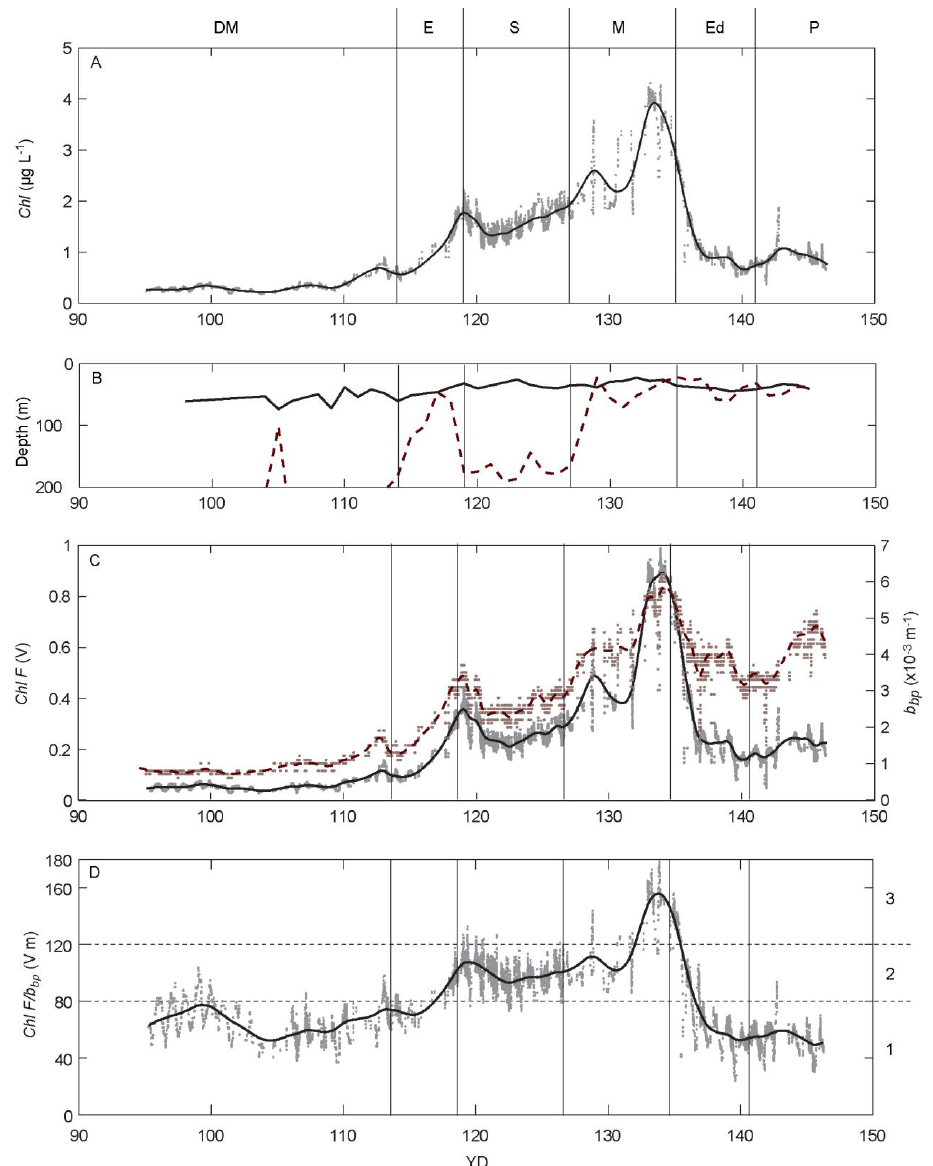
Figure 3. Float data collected for 10 – 50 m for YD 95 –146 (4 April to 25 May 2008). Vertical lines and letters indicate periods in bloom evolution (see Sect. 3.1); DM – Deep Mixing; E – Early Bloom; S – Storm; M – Main Bloom; Ed – Eddy; P – Post Bloom. Dots represent initial median-filtered data (seven-point running median); superimposed line is smoothing spline fit (Matlab code spaps.m, smoothing parameter 0.1). (a) Chl derived from Chl F . (b) Mixed-layer depth (dashed line) and depth of 0.415mol photonsm − 2 d − 1 isolume (solid line). (c) Chl F (solid line) and b bp (heavy solid line). (d) Optical community index, Chl F/b bp ; horizontal dashed lines indicate transitions between Groups 1–2 and 2–3. Also see Fig.